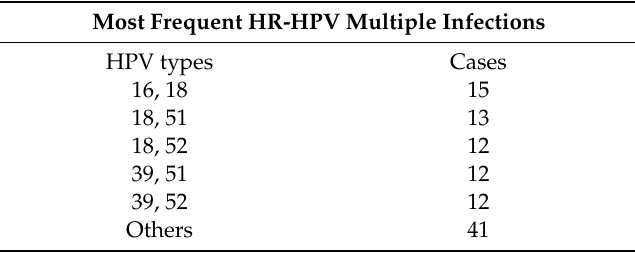
Table 4. Most frequent high-risk human papillomavirus (HR-HPV) types found in multiple infections at the first